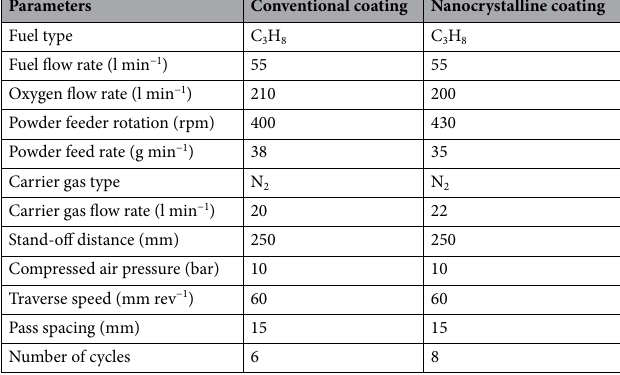
Table 3. HVOF spraying parameters for the as-received and nanocrystalline MCrAlY coatings.